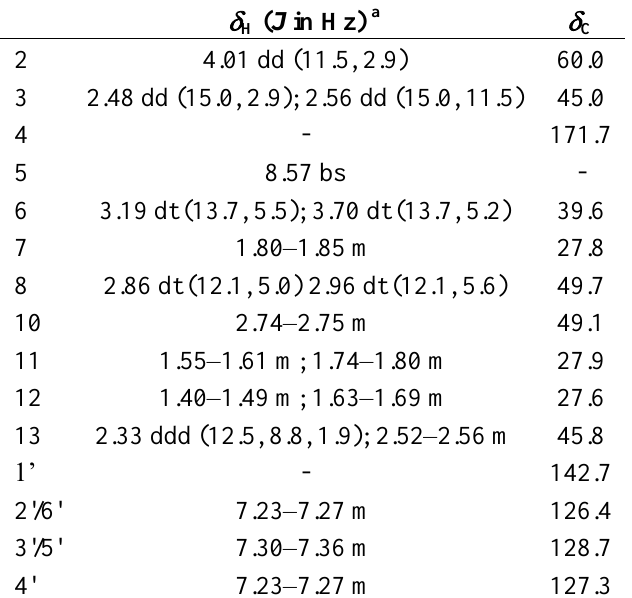
Table 1. 1 H and 13 C-NMR data for compound 1 in CDCl